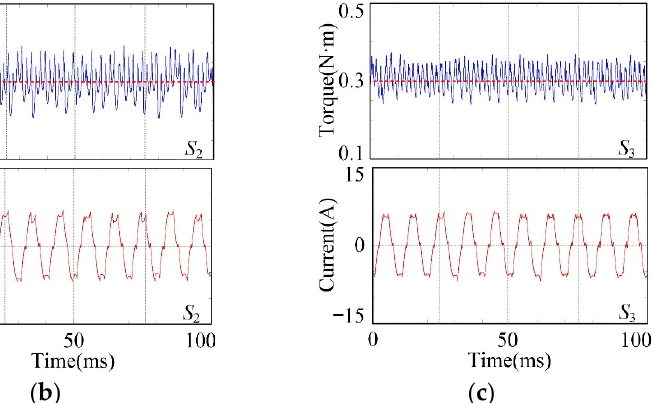
Figure 13. ( a ) Waveforms of torque and phase A current of S 1 under condition 1; ( b ) Waveforms of torque and phase A current of S 2 under condition 1; ( c ) Waveforms of torque and phase A current of S 3 under condition 1.